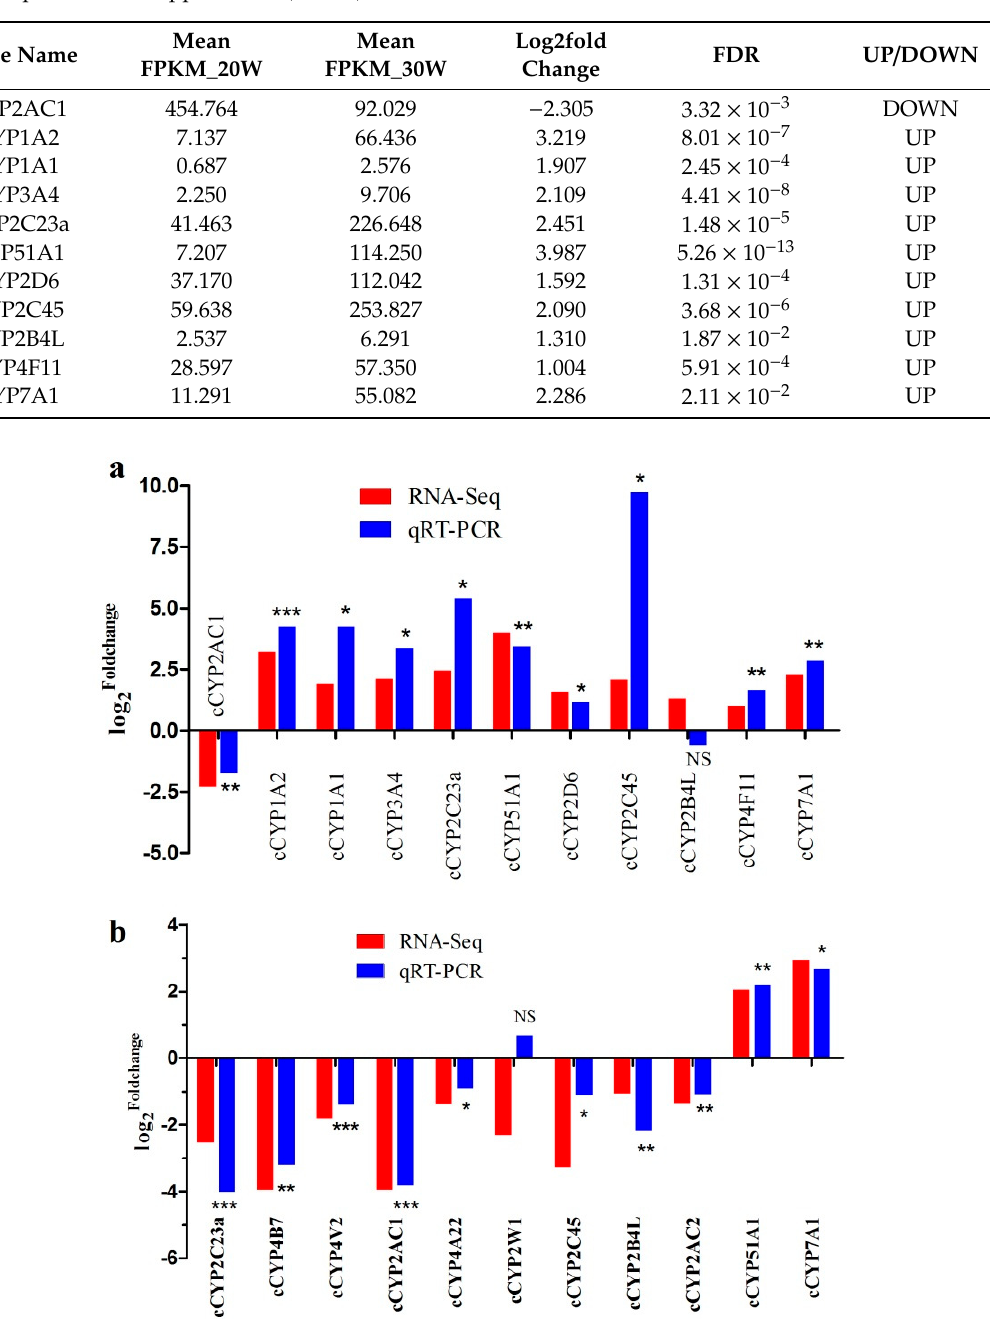
Table 1. Di ff erentially expressed genes between pre-laying and laying hens. Fragments per kilobase of exon per million mapped reads (FPKM).